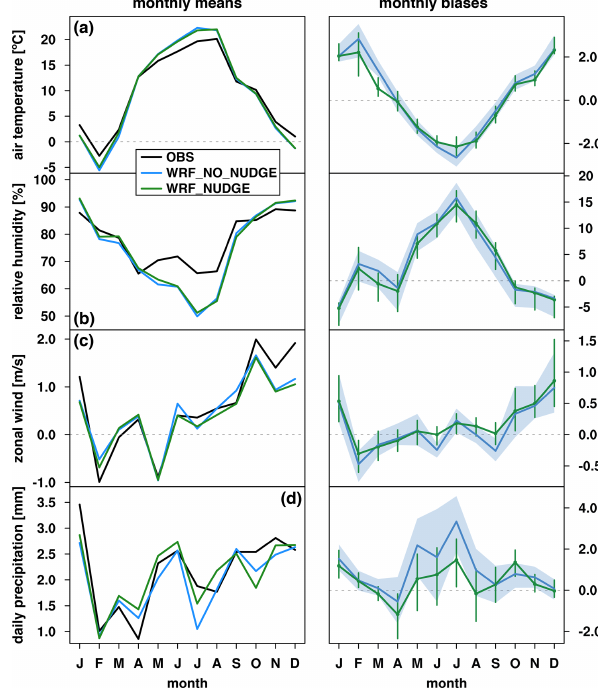
Figure 4. Time series of monthly mean 2m (a) air temperature and (b) relative humidity, (c) 10m zonal winds, and (d) daily to- tal precipitation (left column) between September 2017 and Au- gust 2018. Observational, WRF_NO_NUDGE and WRF_NUDGE data are shown in black, blue and green, respectively. Time series of monthly mean biases of the same variables (right column). The mean bias over all stations is shown for each simulation using the same colour assignment, while the lower and upper quartiles of the station biases are shown as a blue polygon and green bars for WRF_NO_NUDGE and WRF_NUDGE data,